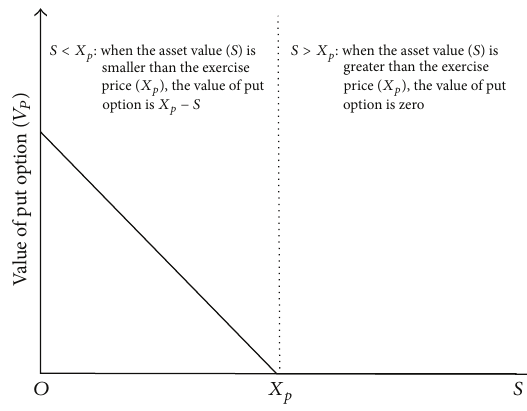
Figure 1: The value of put option depending on the change of the asset